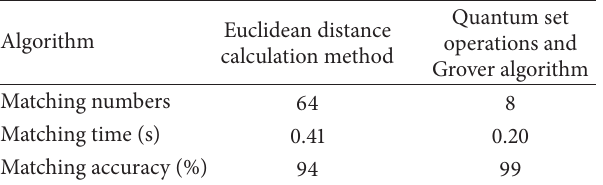
Table 2: Cross-validation experiment results of traditional algo- rithm and our